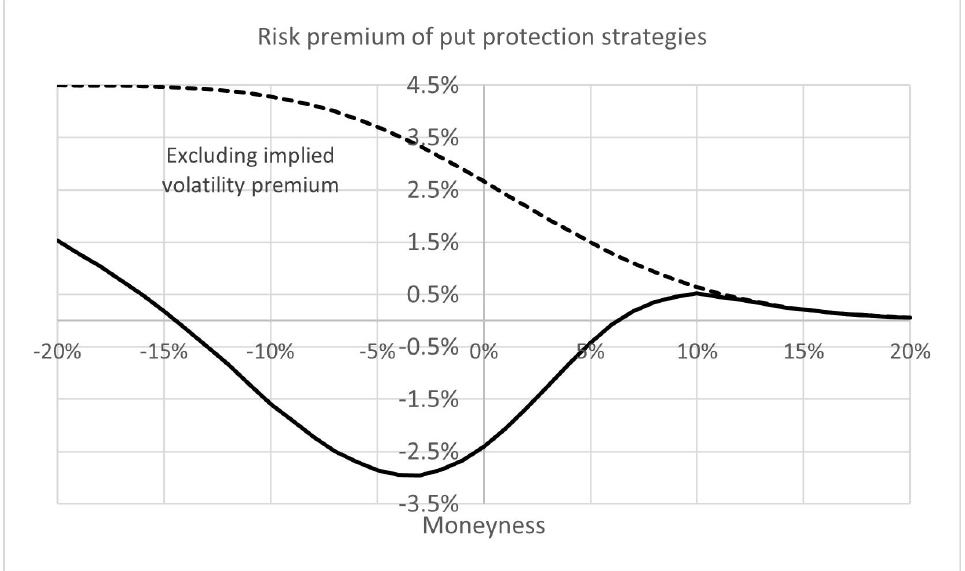
Figure 10. The risk premium for an underlying asset with an overlaid put protection strategy for a range of strike prices. The dotted line assumes the implied volatility is equal to the underlying asset volatility. The solid line includes the implied volatility premium in the price of the